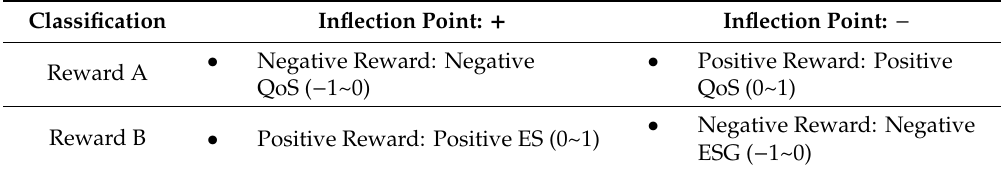
Table 11. Relationship of reward and inflection point.